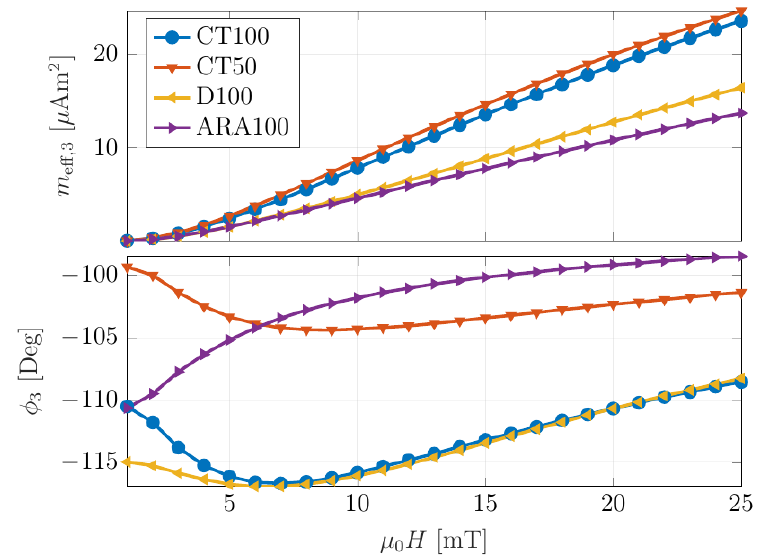
Figure 2. Effective magnetic moments ’ response of the 3rd harmonic for 150 μL of different MNPs type.